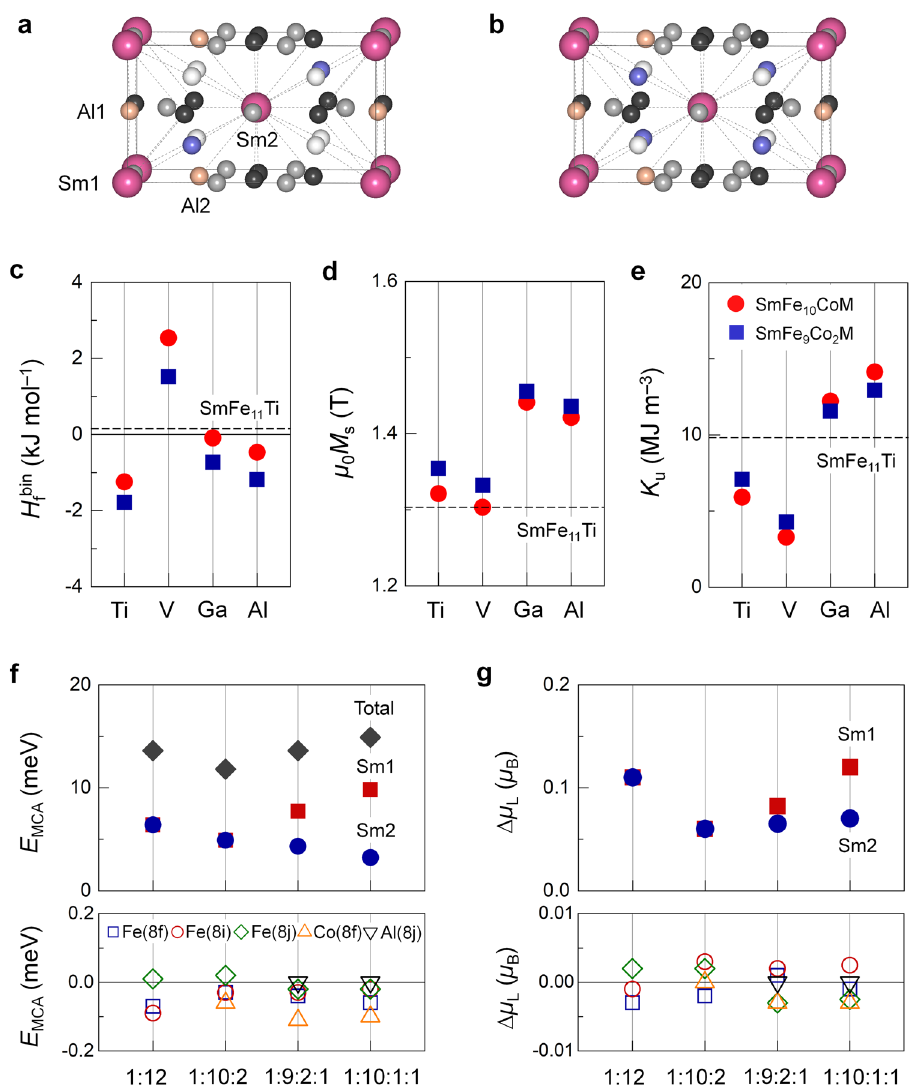
Fig. 5 Impact of multielement substitution on the stability and intrinsic magnetic properties at 0 K. Optimized atomic structures of a SmFe 10 CoAl and b SmFe 9 Co 2 Al. Blue and orange spheres represent the Co and Al substitutional atoms, respectively. Other atomic symbols , d saturation magnetization μ 0 M s , and e uniaxial magnetocrystalline anisotropy are the same as those used in Fig. 1. c Formation enthalpy H bin f K u of SmFe 10 CoM and SmFe 9 Co 2 M for M = Ti, V, Ga, and Al. Horizontal dashed lines correspond to the calculated results of SmFe 11 Ti for reference. f Atom-by-atom contribution to magnetocrystalline anisotropy energy E MCA and g orbital magnetic anisotropy Δ μ L of SmFe 12 (denoted as 1:12), SmFe 10 Co 2 (1:10:2), SmFe 9 Co 2 Al (1:9:2:1), and SmFe 10 CoAl